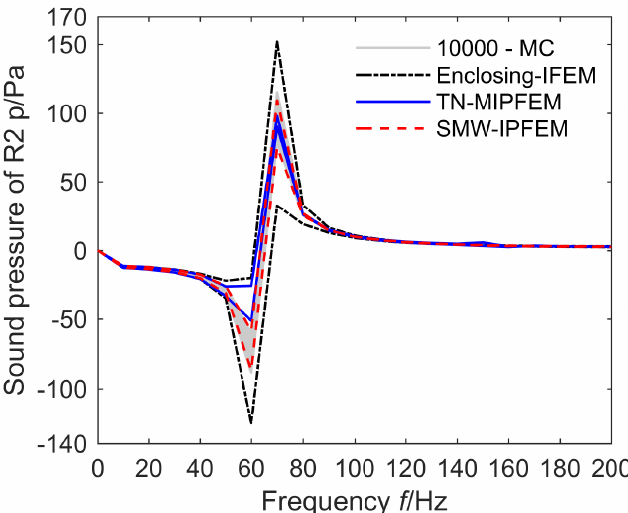
Figure 13. The sound pressure at the point of